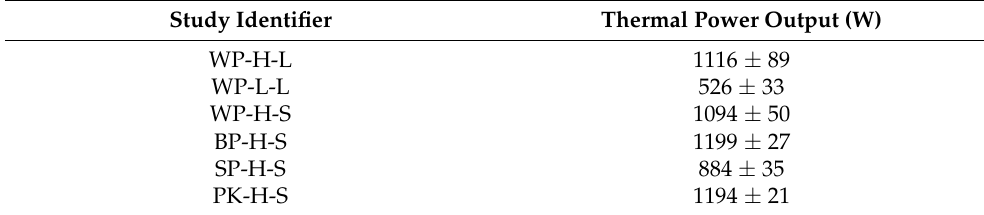
Table 4. Thermal power output of the Apeli